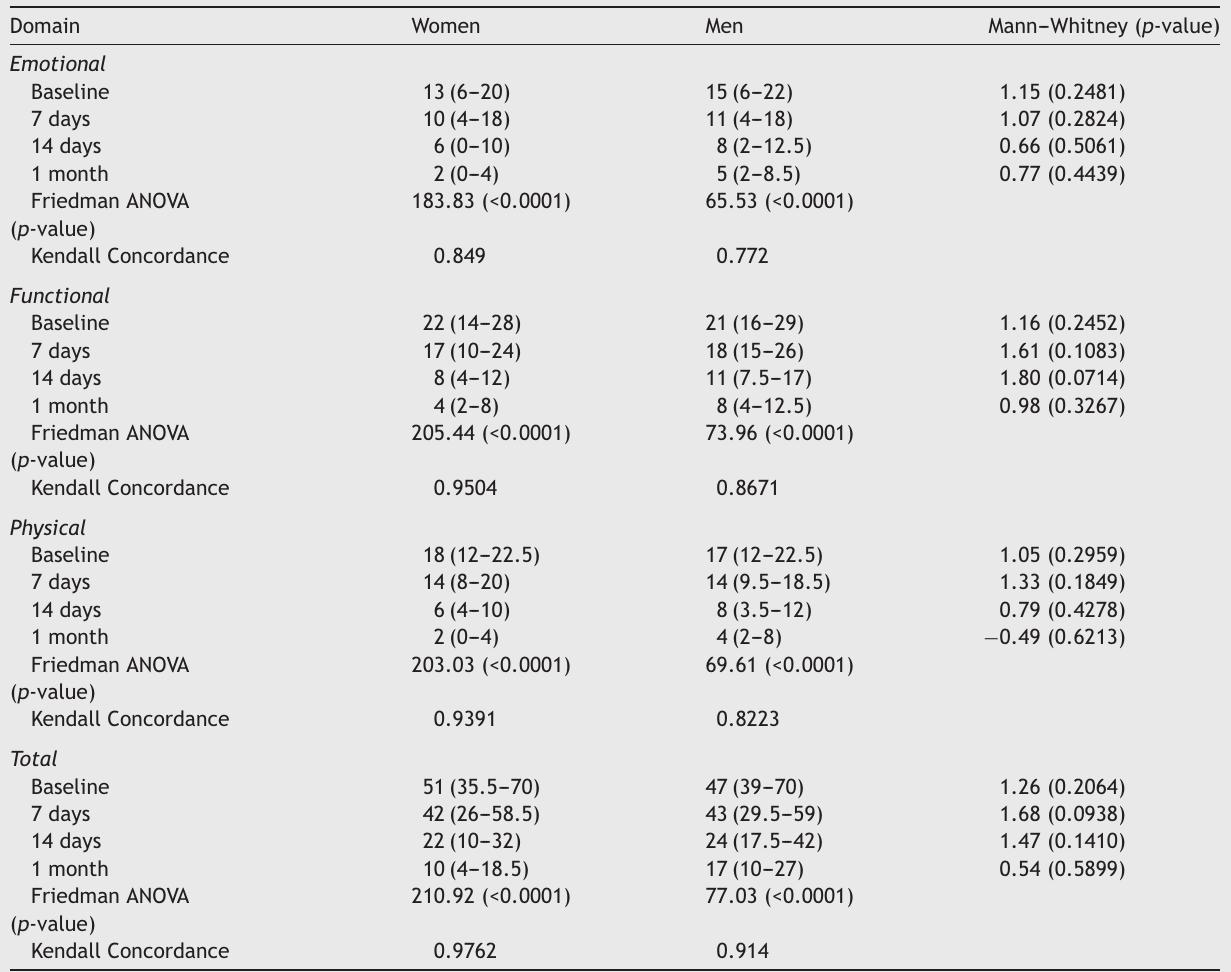
Table 1 DHI scores at the baseline, 7 and 14 days, and 1 month. Domain